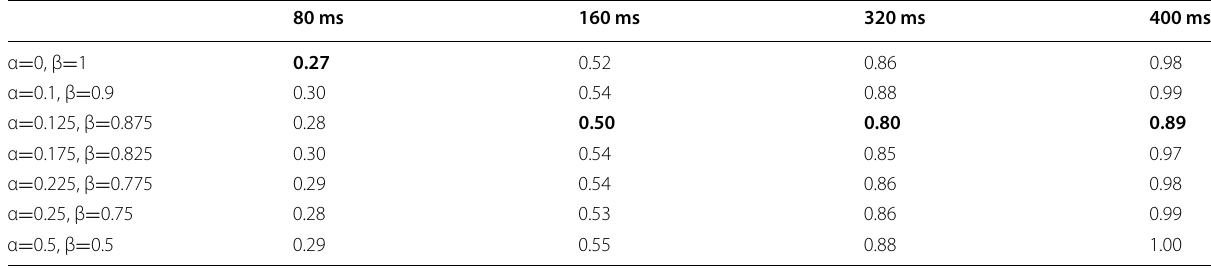
The best results are presented in